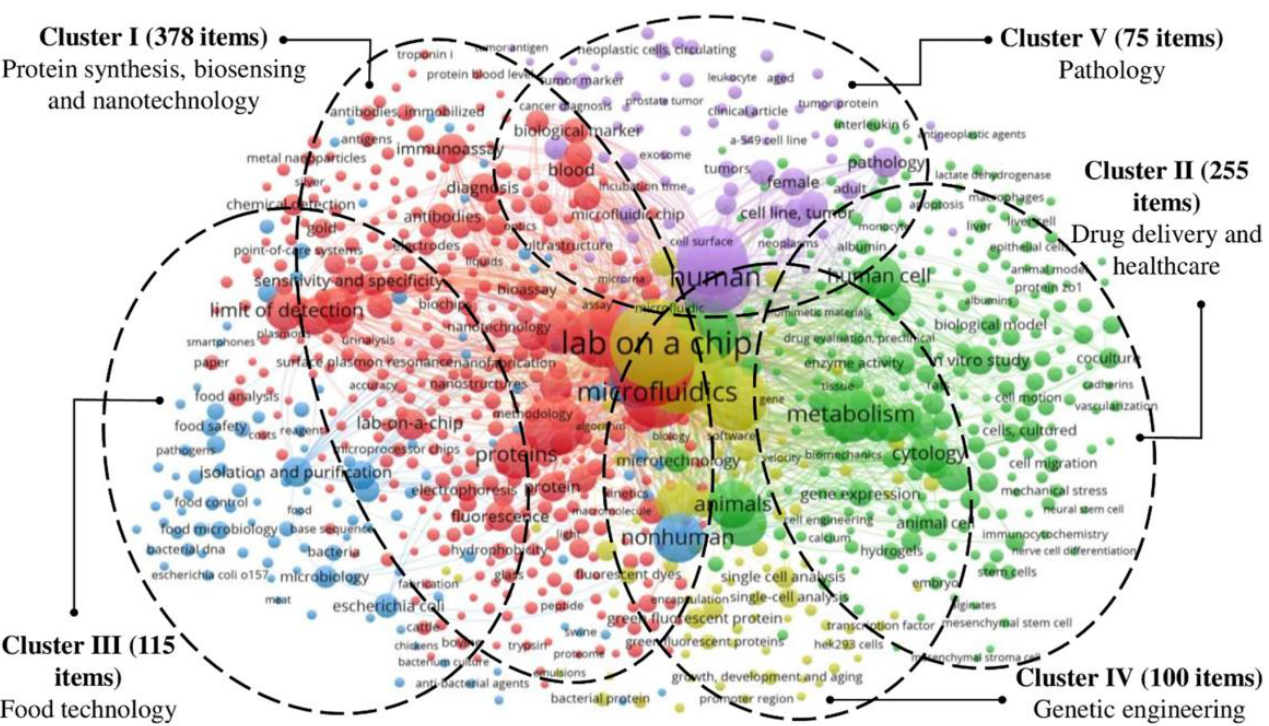
Figure 13. Lab-on-chip themes using a wordlist cluster investigation of the bibliometric data extracted from Scopus using VOS viewer software. Wordlist cluster investigation was performed to determine the research hotspots and developments in the last two decades. Copyright with permission from ref. [153] Springer.